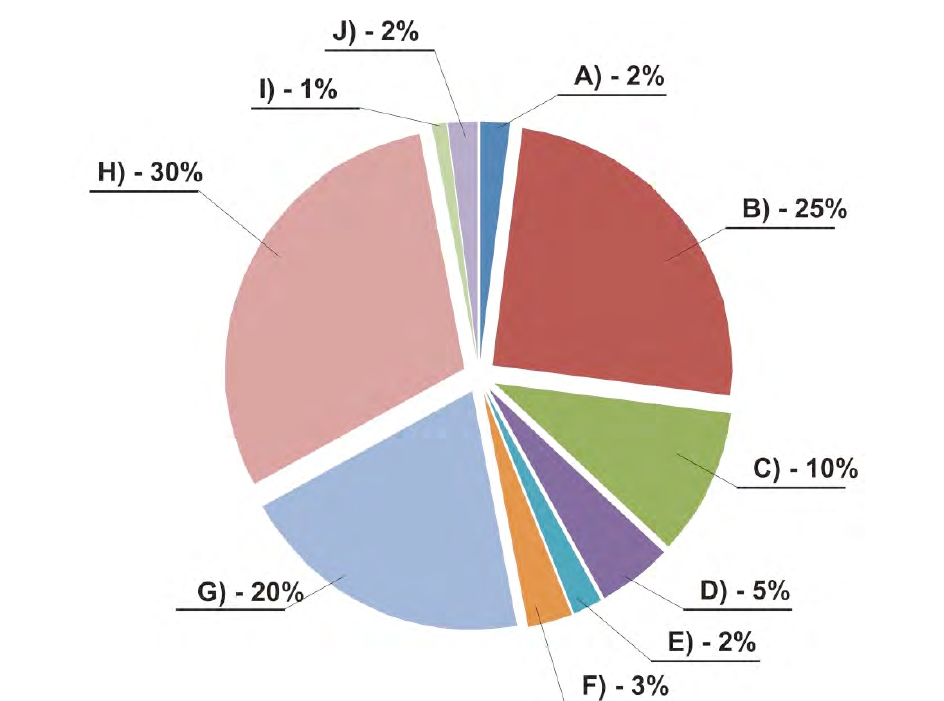
Fig. 1. The structure of the risks of drivers’ occupational morbidity, who carry out passenger transport by bus [1]: A) - Diseases of the nervous system; B) - Diseases of the circulatory system; C) - Diseases of the respiratory system; D) - Diseases of the digestive system; E) - Diseases of the genitourinary system; F) - Diseases of the endocrine system;